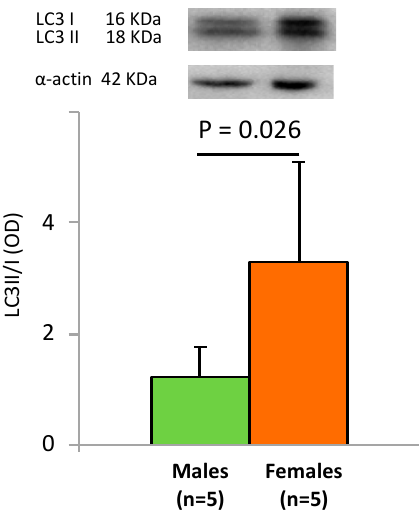
Figure 3. LC3 II/I ratio autophagic marker. Representative Western blot and densitometric analysis of LC3II/LC3I ratio in male and females WJ-MSCs. Values are expressed as means + SD from at least 5 experiments and normalized to actin levels.